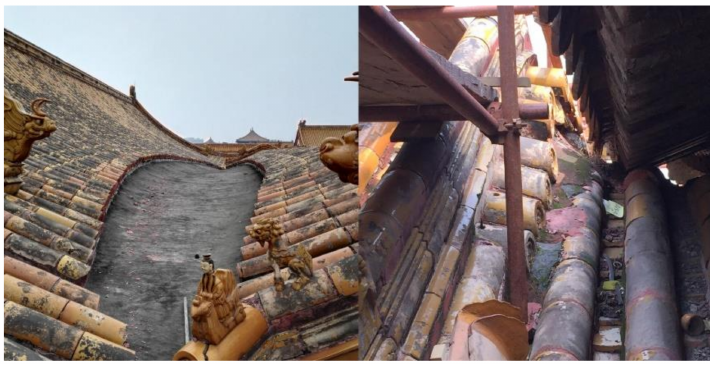
Figure 3. The photos of gutter and falling watershed.